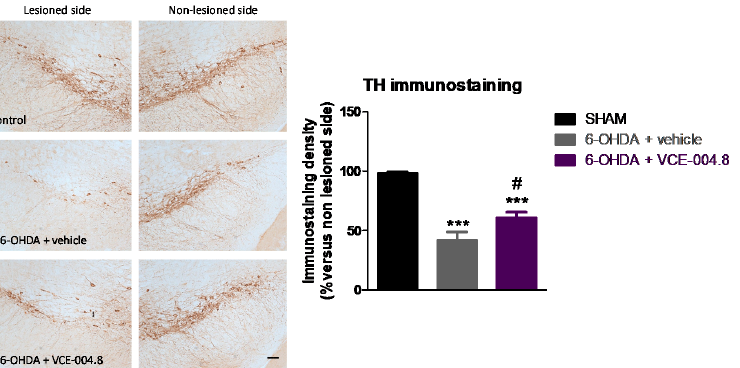
Figure 3. Intensity of the immunostaining for TH measured in a selected area of the substantia nigra pars compacta of control (sham) mice and unilaterally 6-OHDA-lesioned animals treated with VCE-004.8 (20 mg/kg) or vehicle (Maisine CC/corn oil) given orally. Treatments were daily and prolonged for 2 weeks. Data corresponded to percentage of the ipsilateral lesioned side versus contralateral non-lesioned side at 24 h after the last dose and were expressed as means ± SEM of more than 5 animals per group. They were analyzed by one-way ANOVA followed by the Bonferroni test (*** p < 0.005 versus sham; # p < 0.05 versus 6-OHDA + vehicle). Representative immunostaining images for each experimental group are shown in the left panels (scale bar = 100 µm).